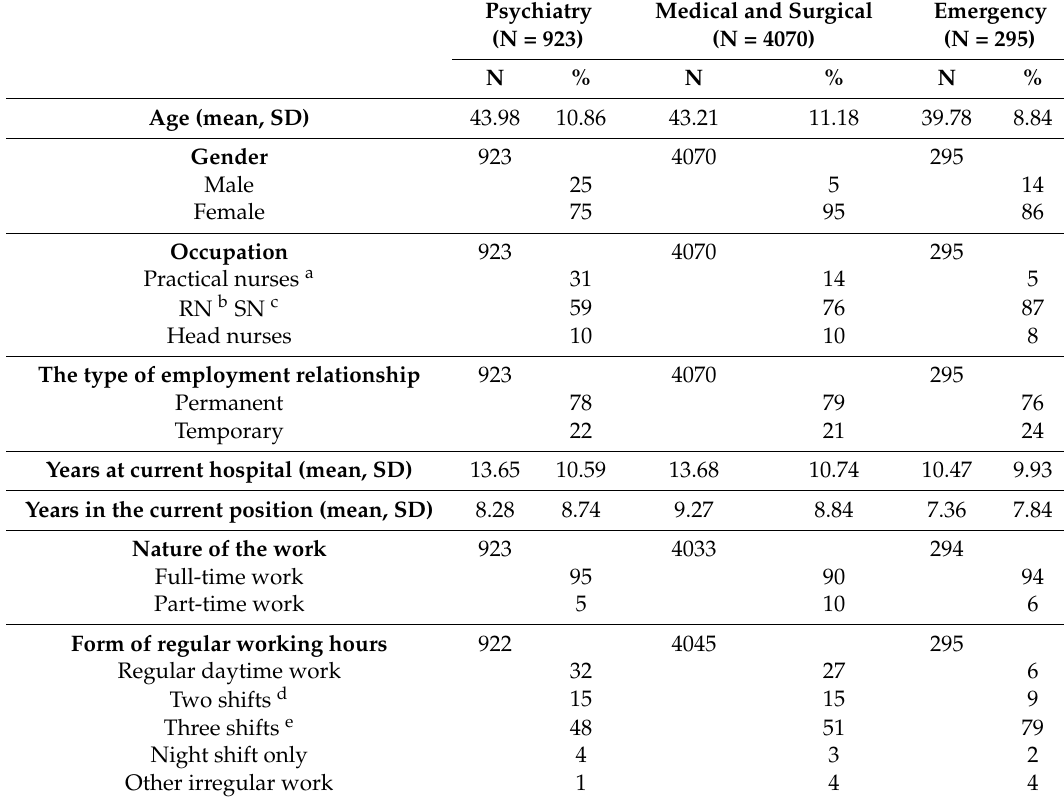
Table 1. Demographic information of nurses working in different specialties (Finland,